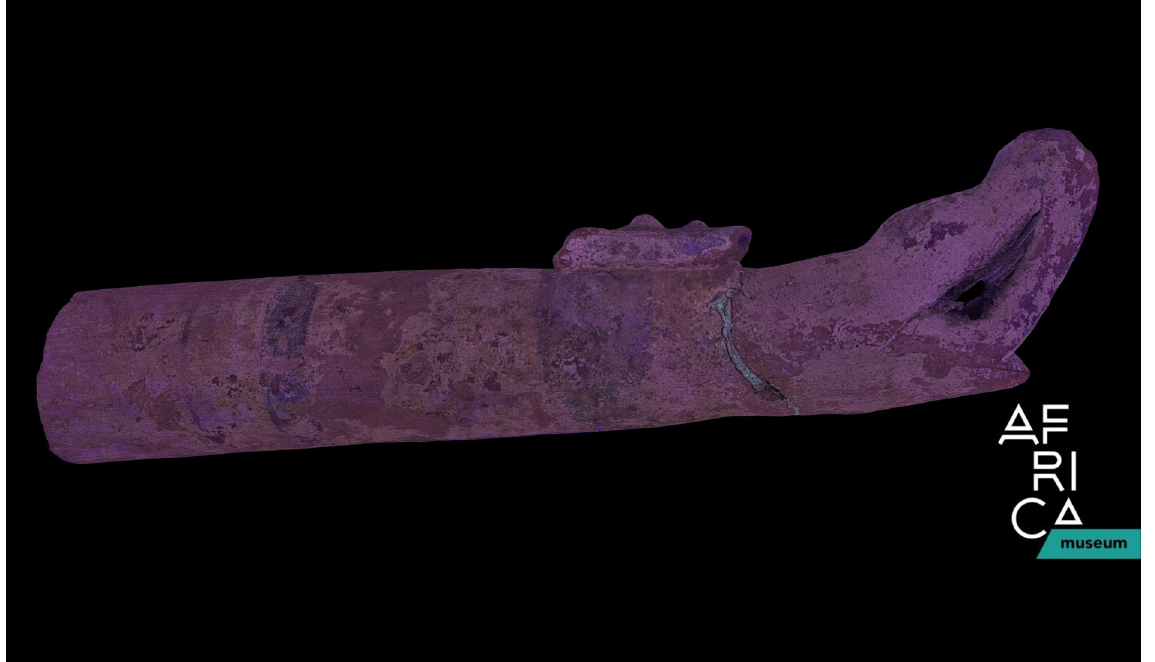
Fig. 4.9. Pre-Columbian handle of an incense shovel from the Royal Museum of Art and History collections. UV fluorescence photogrammetry model. In this case, fluorescence enables to enhance the glue (fluorescing in green).